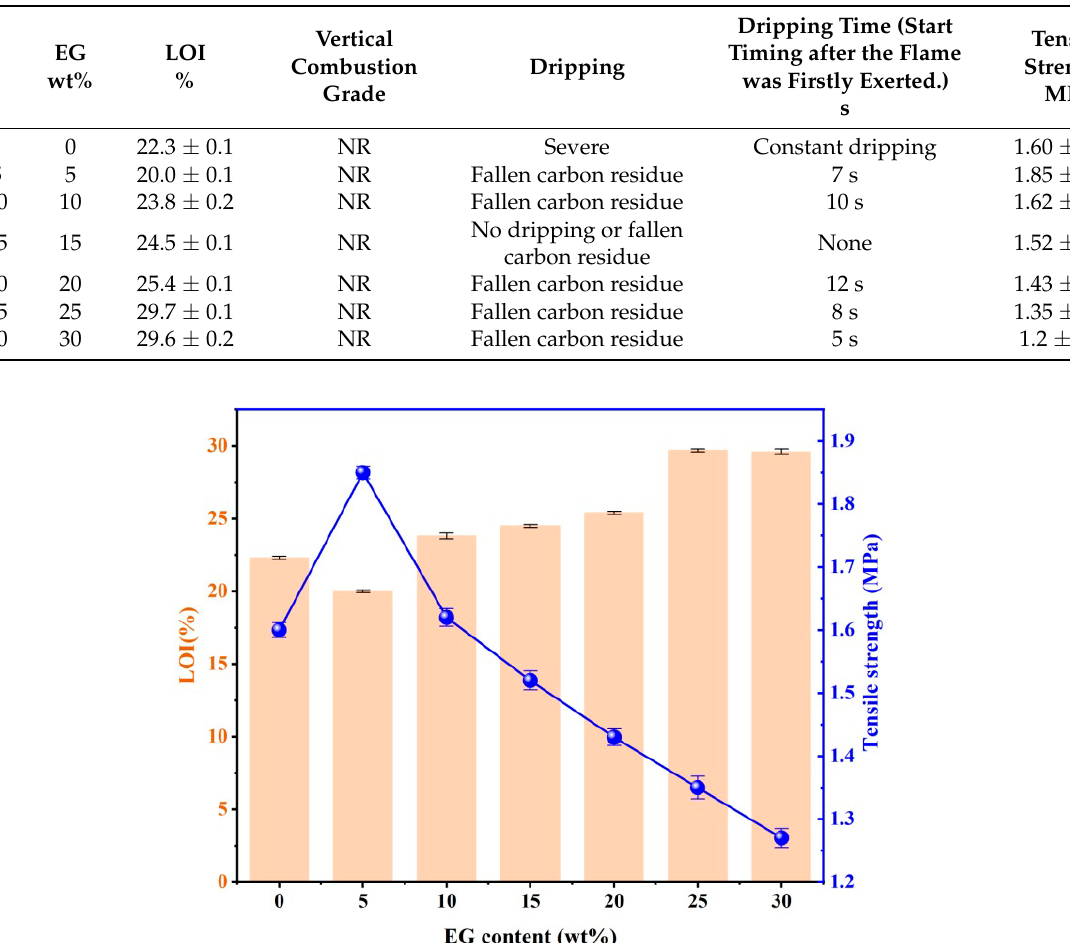
Table 6. Effect of EG on the overall properties of MPUE.